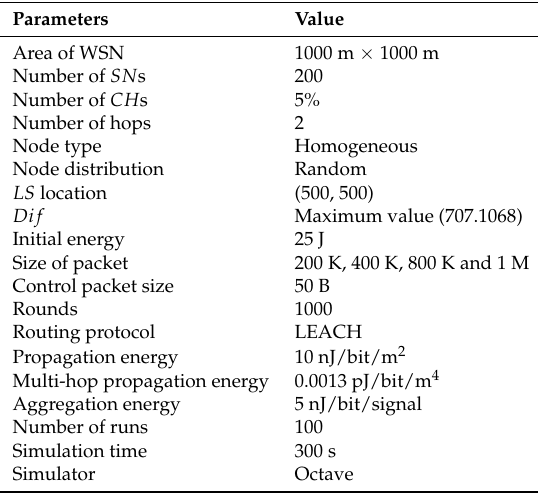
Table 4. REISCH’s simulation parameters.